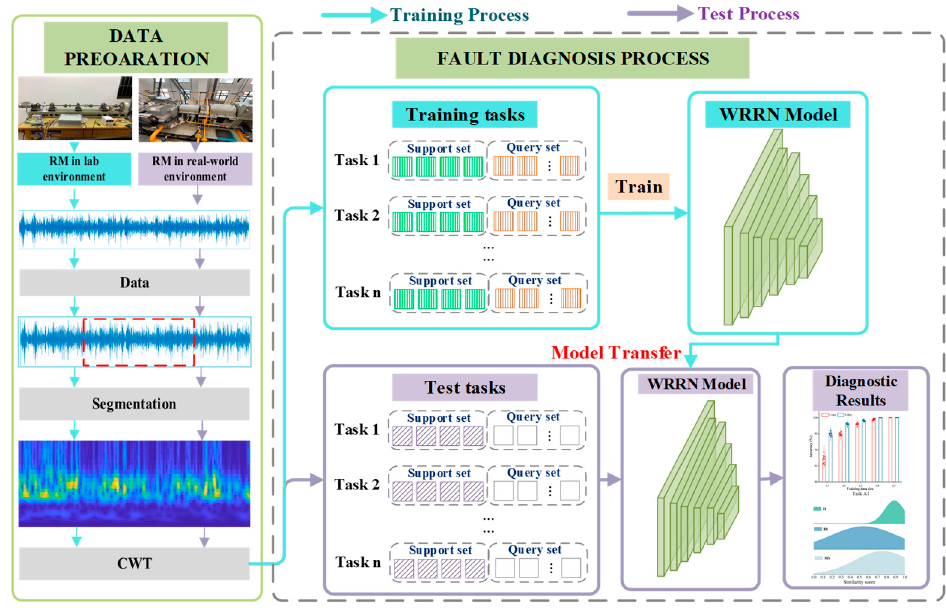
Figure 2. Fault diagnosis pipeline based on the WRRN method.